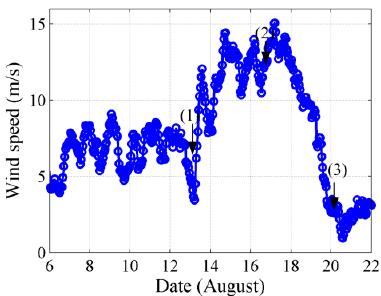
Figure 10. The wind speed as a function of time during experimental measurement.